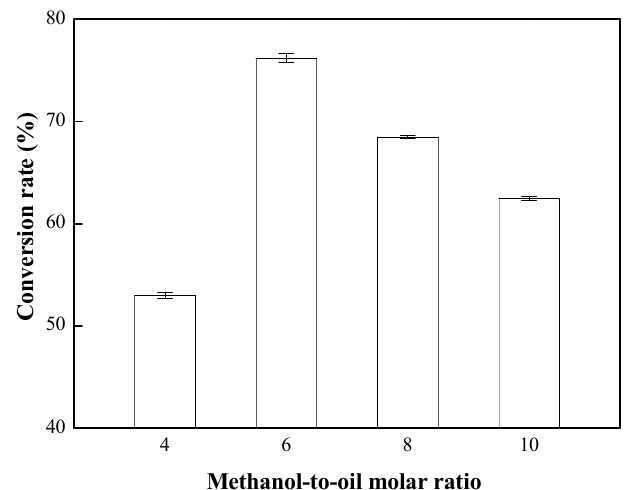
Figure 5. Effect of methanol-to-oil molar ratio on the transesterification reaction. Reaction conditions: catalyst amount: 4 wt %; rotation speed: 7000 rpm; reaction temperature: 65 °C; reaction time: 60 min; catalyst amount: 4 wt %; rotation speed: 7000 rpm; reaction temperature: 65 ◦ C; reaction time: 60